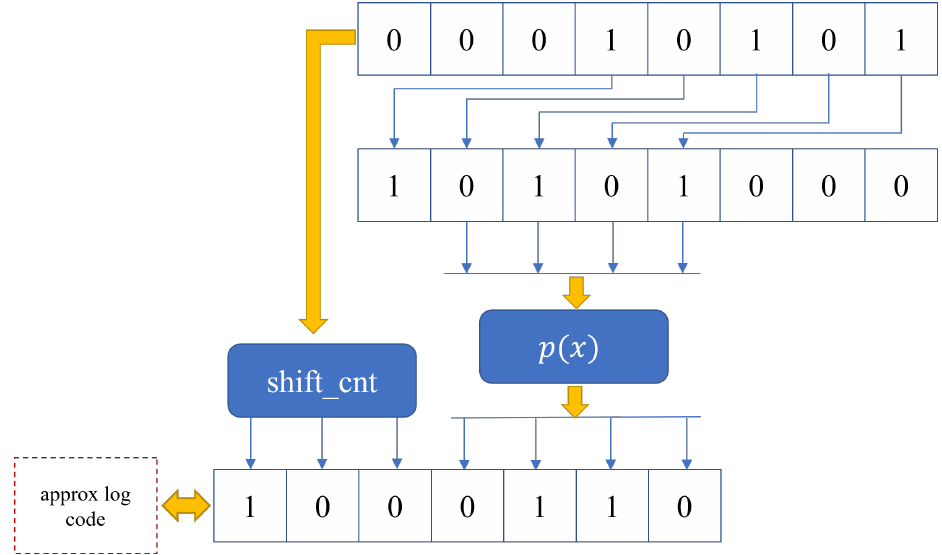
Figure 3. Pwl-Mit algorithm approximate logarithm code